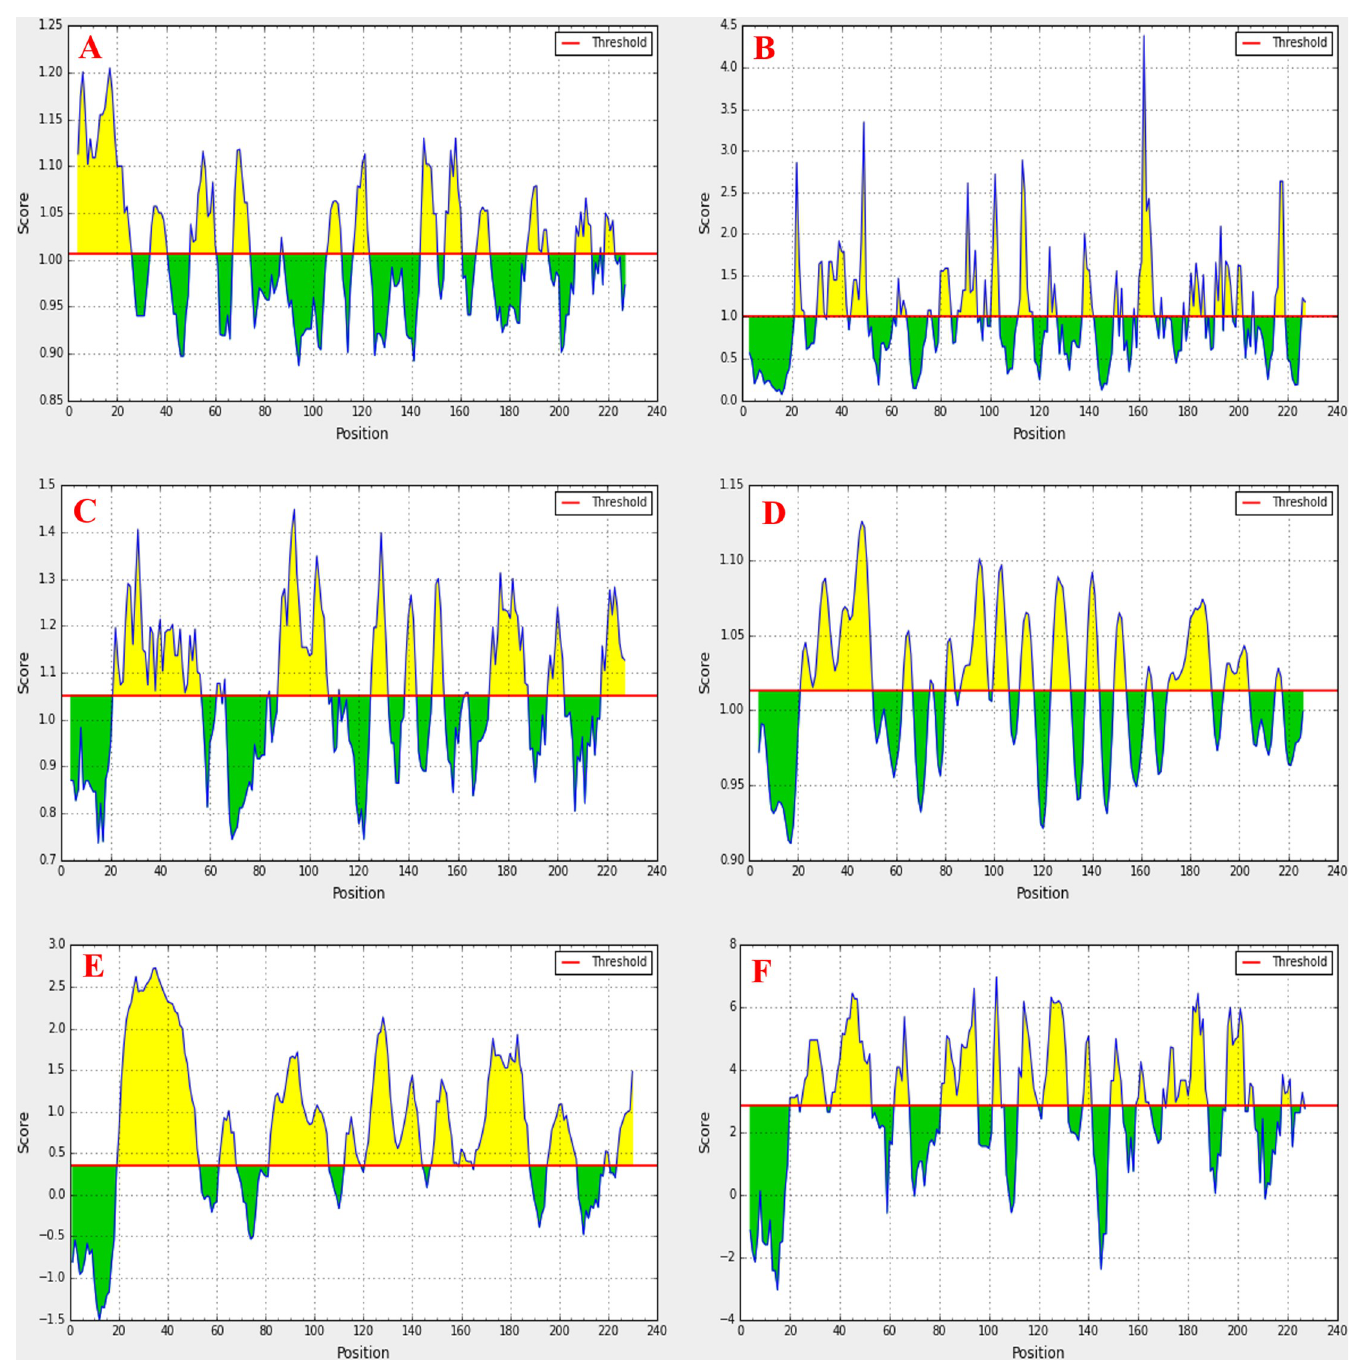
Fig 5. Prediction of B cell epitope properties for the conserved antigenic region. Region 34–42 (PAAPQPSAS) possessed the maximum antigenic criteria as a potential B cell epitope. (A) Kolaskar and Tongaonkar antigenicity prediction, (B) Emini surface accessibility prediction. (C) Chou and Fasman beta-turn prediction, (D) Karplus and Schulz flexibility prediction, (E) Bepipred linear epitope prediction, (F) Parker hydrophilicity prediction. The regions with antigenic nature are shown in yellow color.